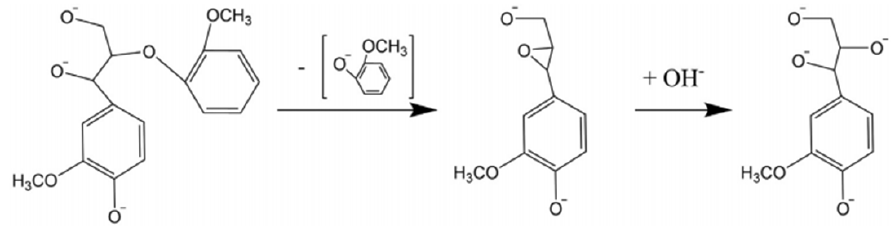
Figure 4. Base catalyst mechanism for the cleavage of β -O-4 linkages, adapted from [49].